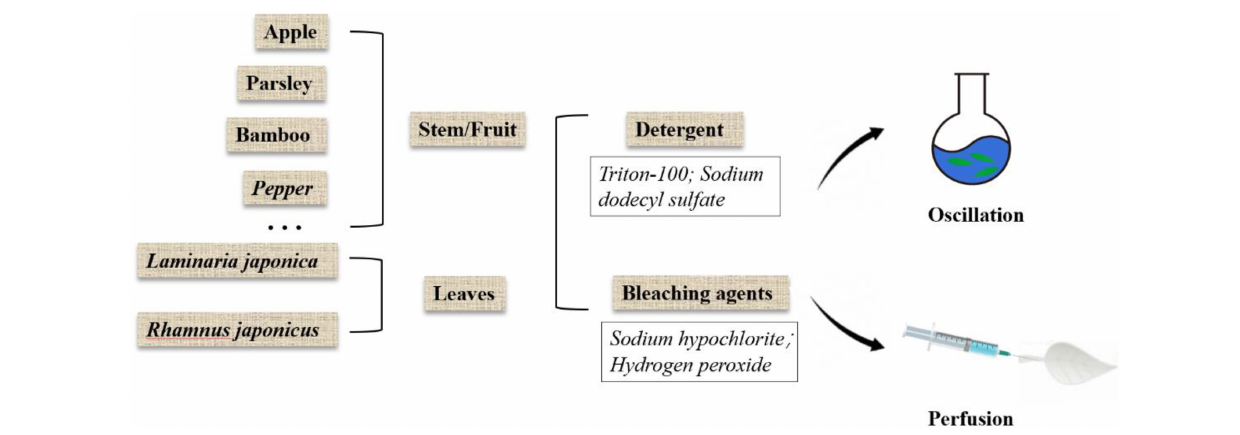
FIGURE 1 | Overview of plant decellularization